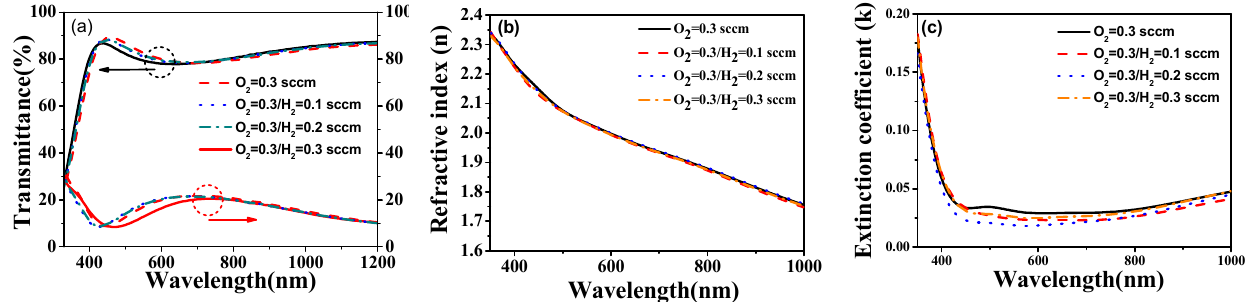
Figure 4. ( a ) Transmittance and reflection spectra, ( b ) the fitted refractive index (n) and ( c ) extinction coefficient (k) of ITO films deposited at various hydrogen flows at an oxygen flow of 0.3 sccm as a function of wavelength.